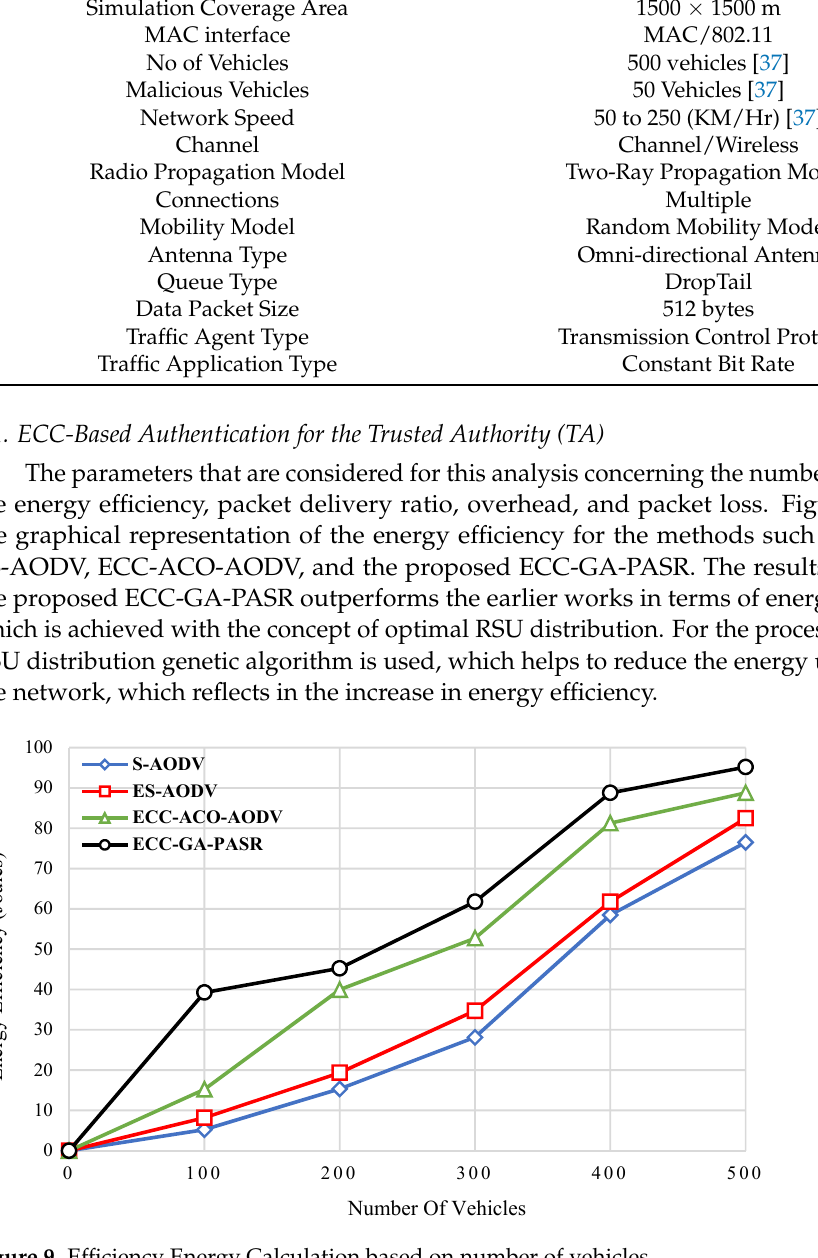
Figure 9. Efficiency Energy Calculation based on number of vehicles.